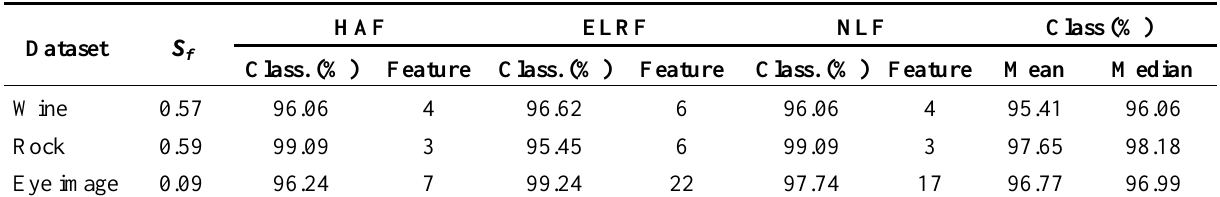
Table 10. Results of selected features by HAF, ELRF, and NLF methods using k –NN voting classifier with k = 5.